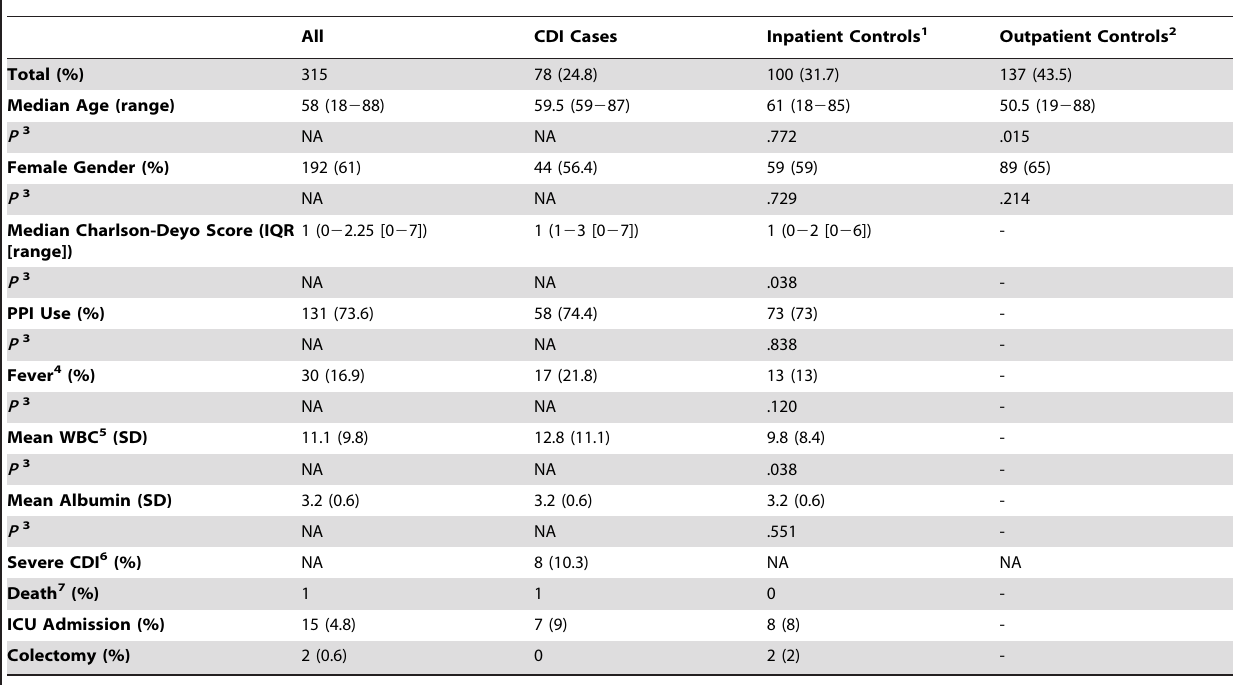
Table 2. Patient